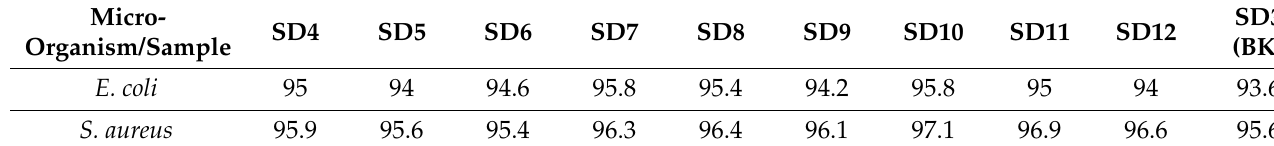
Table 6. Efficacy of removal of E. coli and S. aureus strains from surfaces.